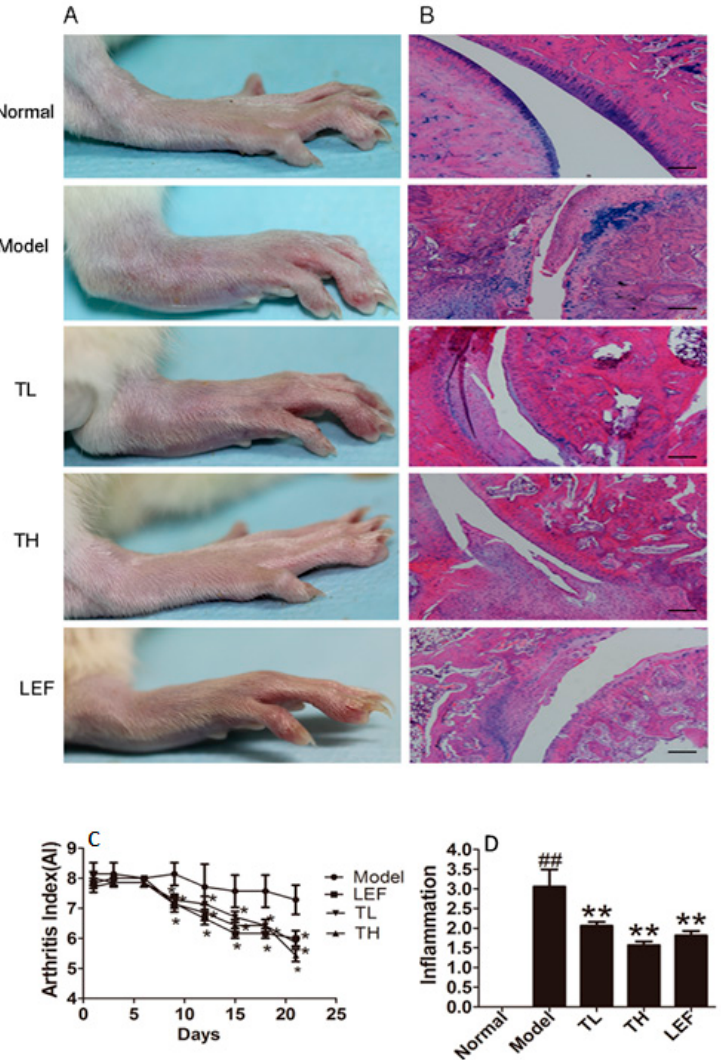
Figure 5. Effects of TP on collagen-induced arthritis (CIA) rats. ( A ) Morphological features of representative ankle joints; ( B ) Histopathological features of representative ankle joints haematoxylin-eosin (HE) staining, ×20, scale bars = 100 μ m; ( C ) Arthritic score in different days after treatment with TP; ( D ) Inflammation scores in different groups after treatment with TP, as described in methods. TL represented for TP low dose (9.31 μ g/kg) group, TH represented for TP high dose (18.62 μ g/kg) group, LEF represented for Leflunomide group. Date are represented as the mean ± SD ( n = 7), ## p < 0.01, comparison with the normal group, * p < 0.05, ** p < 0.01, comparison with the model group.